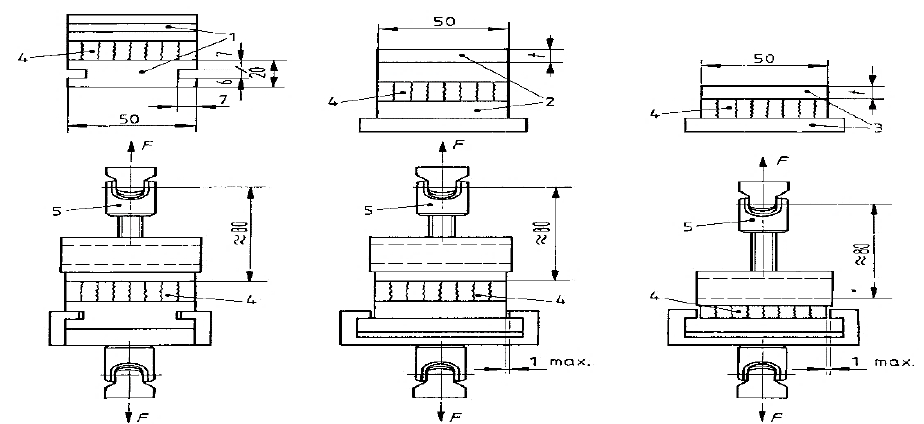
Figure 11. Examples of apparatus for testing tensile strength perpendicular.